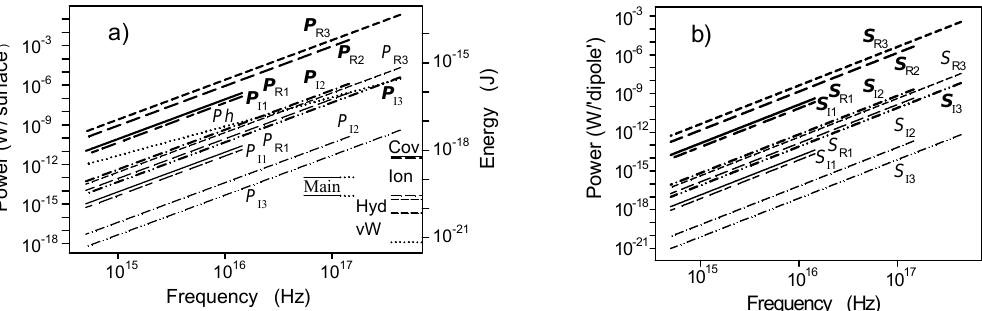
Figure 4. The calculated electromagnetic power propagating in the radial direction between the generating and the receiving dipole and (( a ) integrated over the spherical surface with the radius equal to the distance between the generating and the receiving dipoles ( P symbol), ( b ) integrated over a small area (0.25 nm 2 ) at the receiving dipole projected to the direction perpendicular to the radiation ( S symbol)) is plotted as a function of frequency. Indices 1, 2, and 3 denote phase shifts caused by 1, 2, and 3 periods of oscillations, respectively, the indices R the real and I the imaginary parts of the power. The dipole moment is ( a ) high (the thick lines and description), and ( b ) low (the thin lines and description). Energies of individual bonds are shown in Figure 4a): energy of covalent bonds–Cov, ionic–Ion, hydrogen–Hyd, van der Waals–vW, and the energy values corresponding to a majority of affinity constants are inside the region marked as Main.